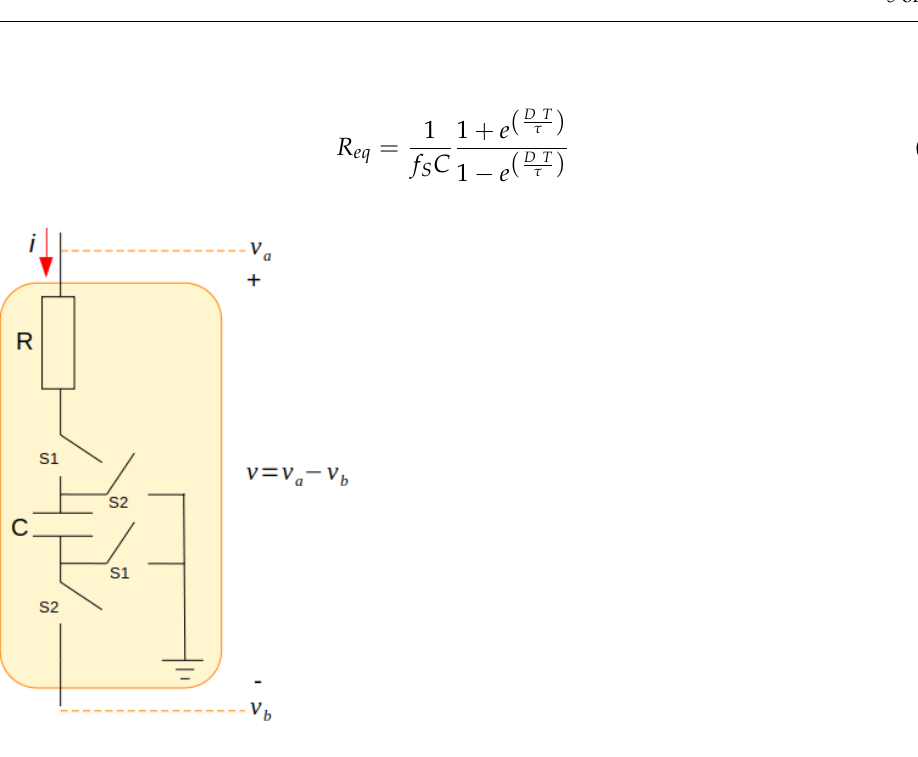
Figure 3. Switched capacitor (SC) circuit